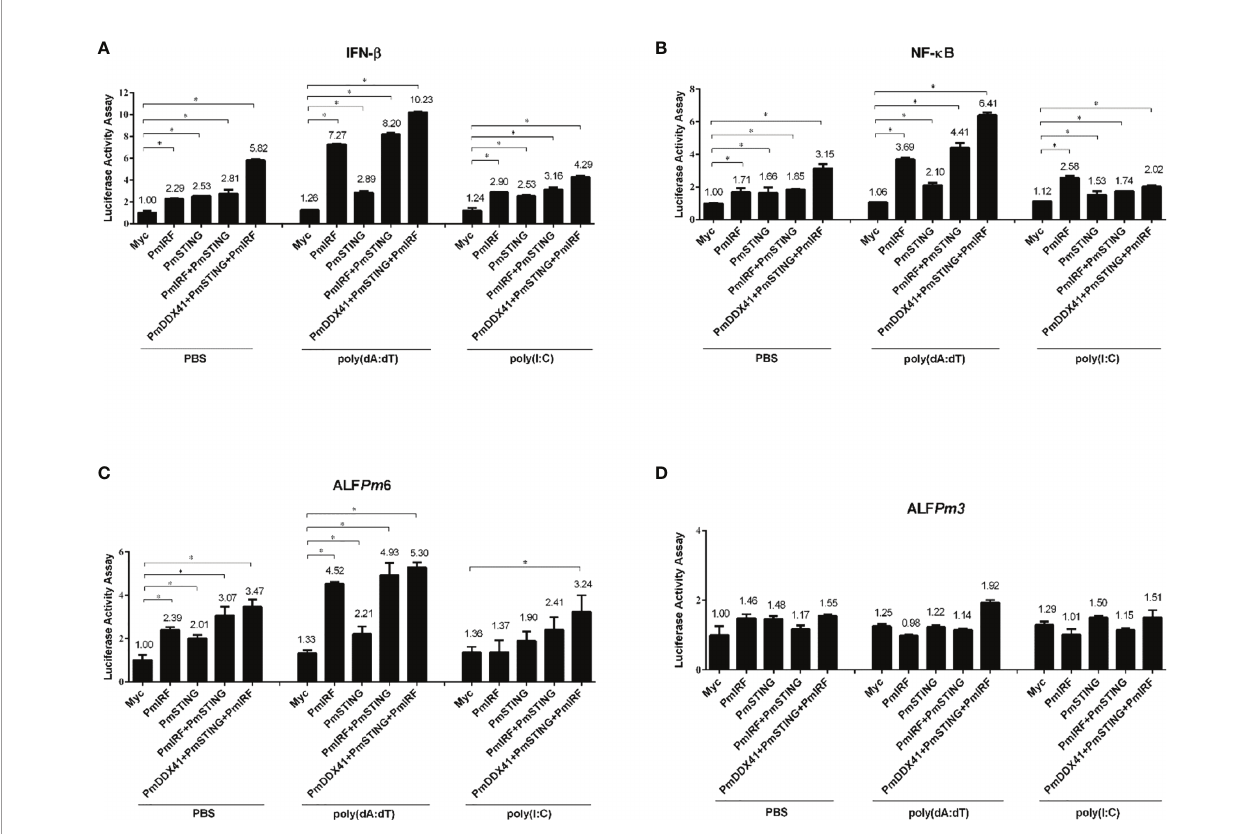
FIGURE 2 | Luciferase assay for promoter activation induced by various immune-related factors in HEK293T cells. (A – D) The activation of IFN- b (A) , NF- k B (B) , ALF Pm 6 (C) , and ALF Pm 3 (D) promoters was evaluated. Cells were co-transfected with 0.5 m g of Flag-tagged Pm IRF expression plasmid and 0.5 m g of Myc tagged- Pm STING along with IFN- b -Luc, NF- k B-Luc, ALF Pm 6-Luc, and/or ALF Pm 3-Luc (all 0.1 m g) plasmid and the Renilla luciferase reporter pRL-TK (0.01 m g) plasmid, then stimulated with poly(dA:dT) or HMW poly(I:C); the luciferase assay was performed after 6 h Data represent mean ± SD of 3 independently replicated experiments. *p <